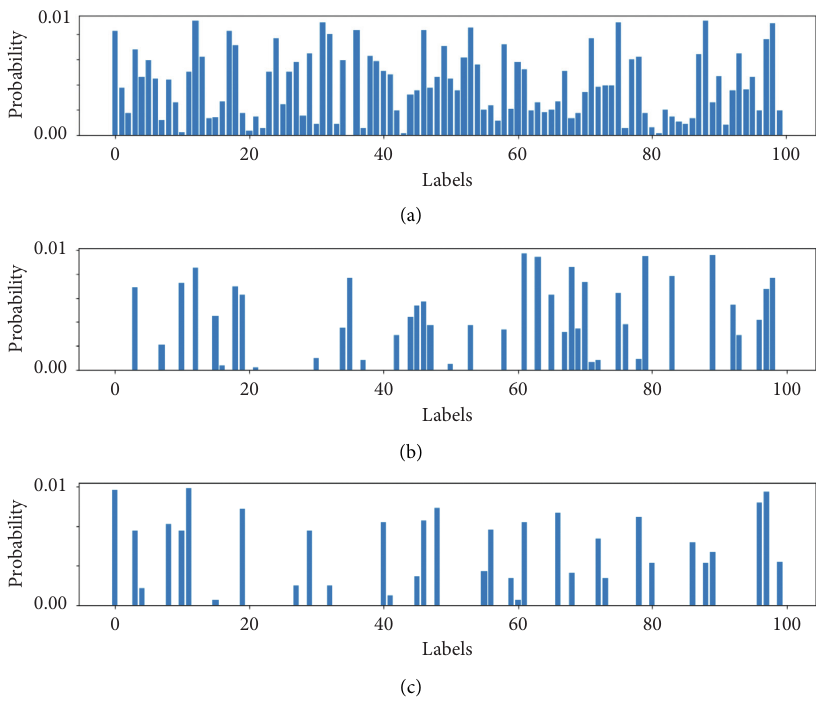
Figure 7: The examples. (a) Rand (0, 1). (b) Rand ( − 1, 1). (c) Rand ( − 2, 1). Table 5: The result of random probability on CIFAR-100 and Mini-ImageNet. Methods on local probability